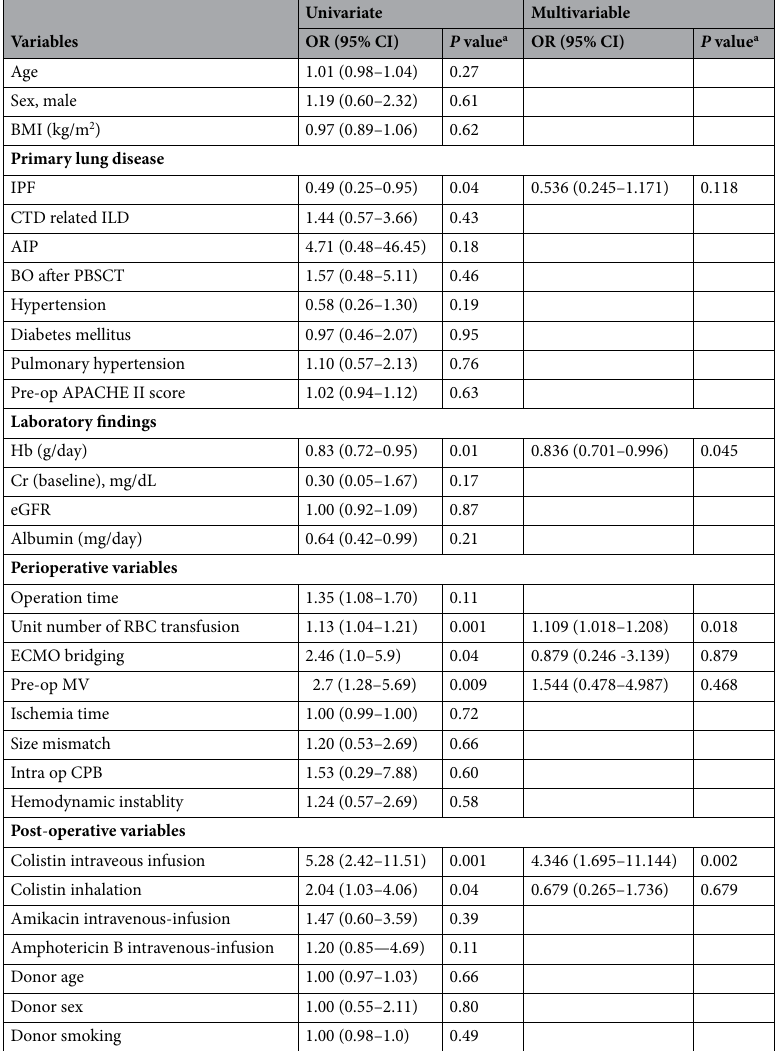
regression model. BMI body mass index, IPF idiopathic pulmonary fibrosis, CTD connective tissue disease, ILD interstitial lung disease, AIP acute interstitial pneumonia, BO after PBSCT Bronchiolitis obliterans after peripheral blood stem cell transplantation, eGFR estimated glomerular filtration rate, Hb hemoglobin, Cr creatinine, ECMO extra corporeal membrane oxygenation, MV mechanical ventilation, RBC red blood cell, APACHE Acute Physiology and Chronic Health